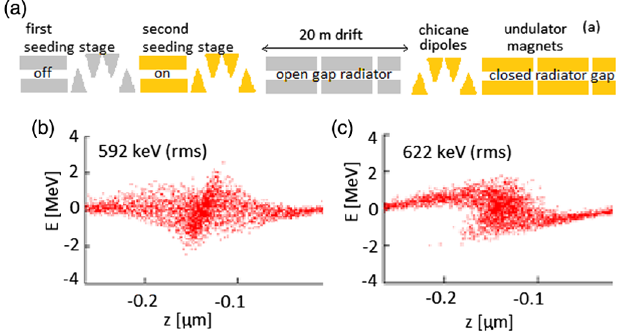
FIG. 9. Velocity-bunched HGHG proposed for FLASH (a), the longitudinal phase space of the microbunches with 10 μ m of dispersion applied at the entrance to the drift (b) and applied after the drift (c). In the 3D simulations, a 1 kA, 700 MeV beam seeded with 4 MeV (peak-to-peak) modulation drifts over 20 m with an average radius of 135 μ m (rms). The bunching factors of both (b) and (c) are 0.05 at the 7th harmonic of the 266 nm seed